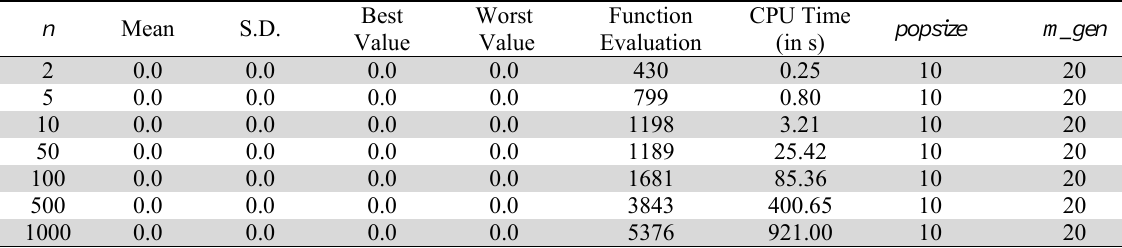
Computational Results of Problem